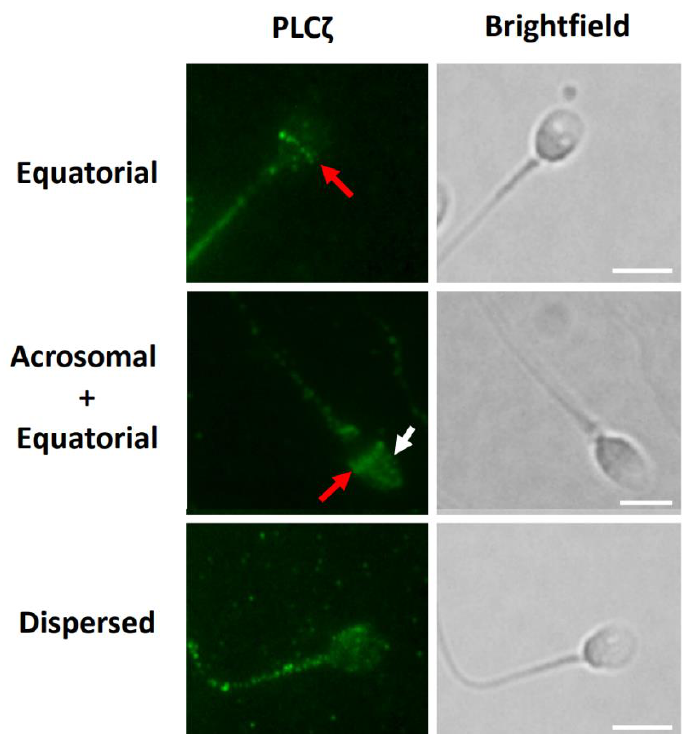
Figure 2. Representative observations of PLC ζ localisation patterns in human sperm under both AUM and no AUM conditions, indicated as appropriate. Representative equatorial (red arrows), acrosomal + equatorial (white arrow indicates acrosomal localisation), and dispersed patterns of localisation are indicated. Fluorescence was also observed throughout the tail and midpiece of all sperm examined. Images obtained were captured at 100 × and white scale bars represent 10 µ m. Images are representative of 100 cells examined per patient recruited (55 patients), for both no AUM and AUM analyses.